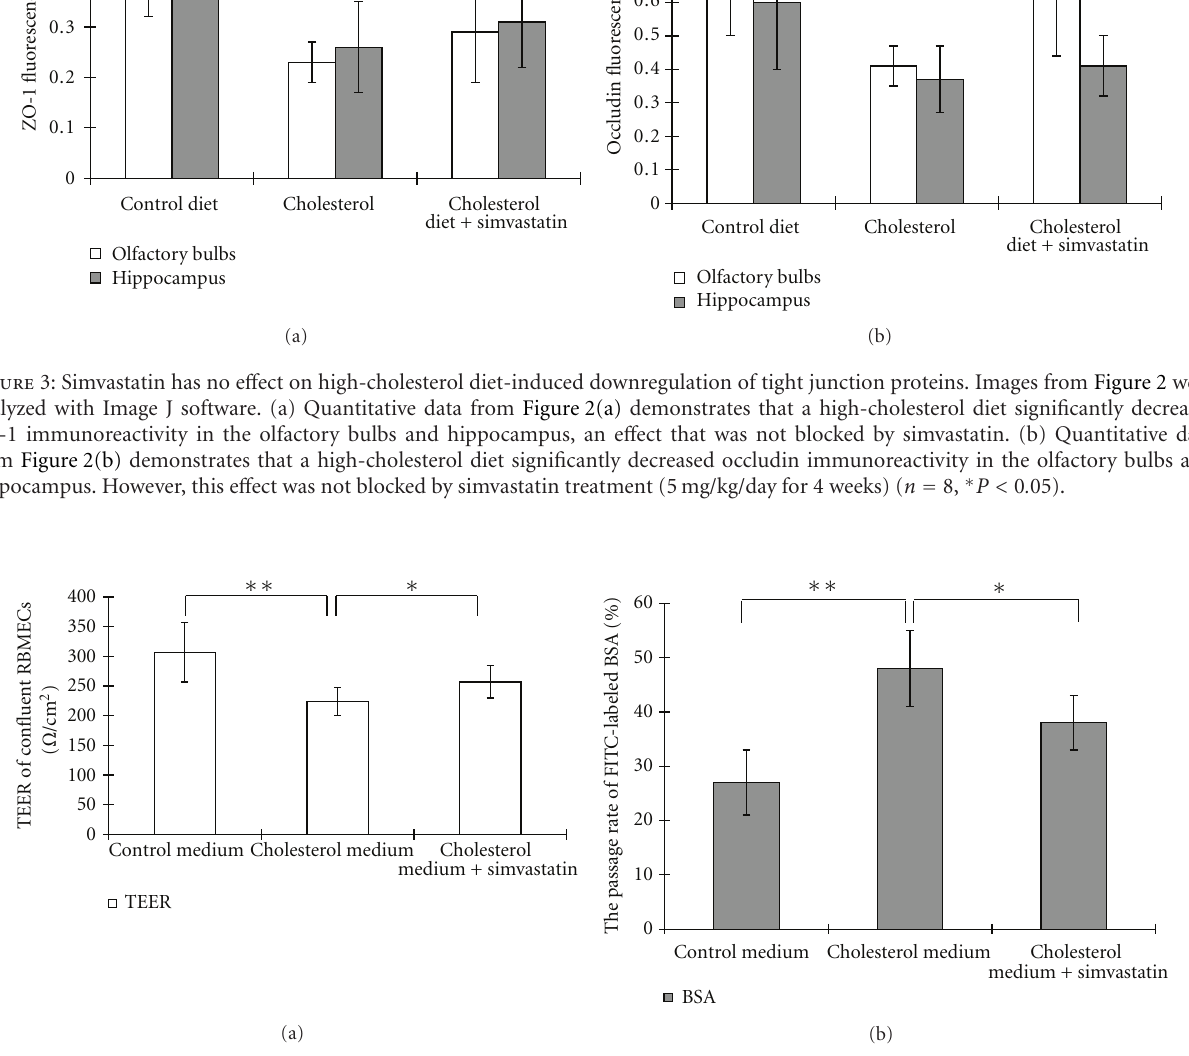
Figure 4: Simvastatin blocks cholesterol-induced TEER decline and transendothelial permeability in vitro. Rat primary brain endothelial cells were stimulated for 24 h with 10 μ M cholesterol in the presence or absence of simvastatin (5 μ M). TEER of confluent RBMECs (a) and permeability of FITC-BSA (b) were measured. Simvastatin significantly blocks both the TEER decline and the increase in FITC-BSA permeability induced by high cholesterol (a, b). TEER was expressed in ohms per square centimeter for electrical resistance ( n = 8, ∗ P < 0 . 05; ∗∗ P < 0 .